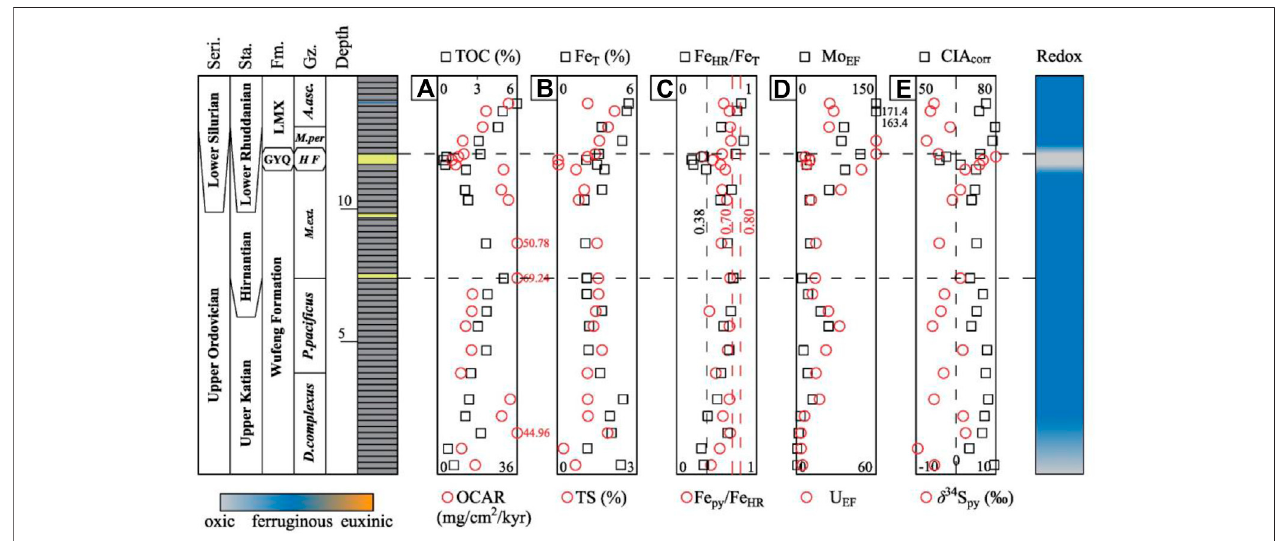
FIGURE 4 | Chemostratigraphic pro fi les of (A) TOC and OCAR, (B) Fe T and TS, (C) Fe HR /Fe T and Fe py /Fe HR , (D) Mo EF and U EF , (E) CIA corr and δ 34 S py , and redox summary for the Tianlin section. The vertical dotted line represents the threshold of each proxy. Abbreviations as in Figure 1 .